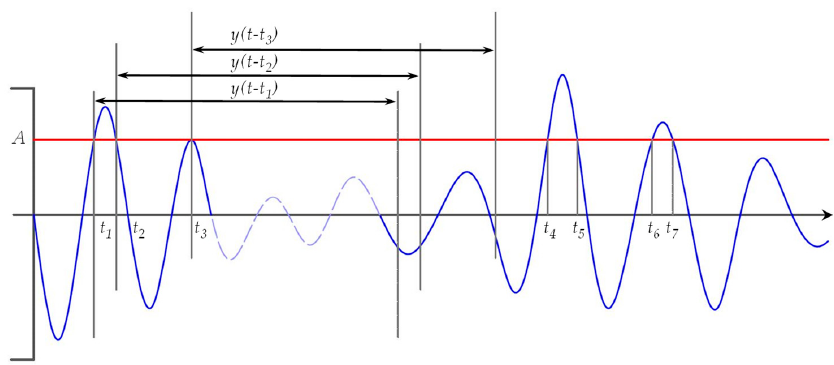
Figure 3. Overview of the random decrement technique (RDT).